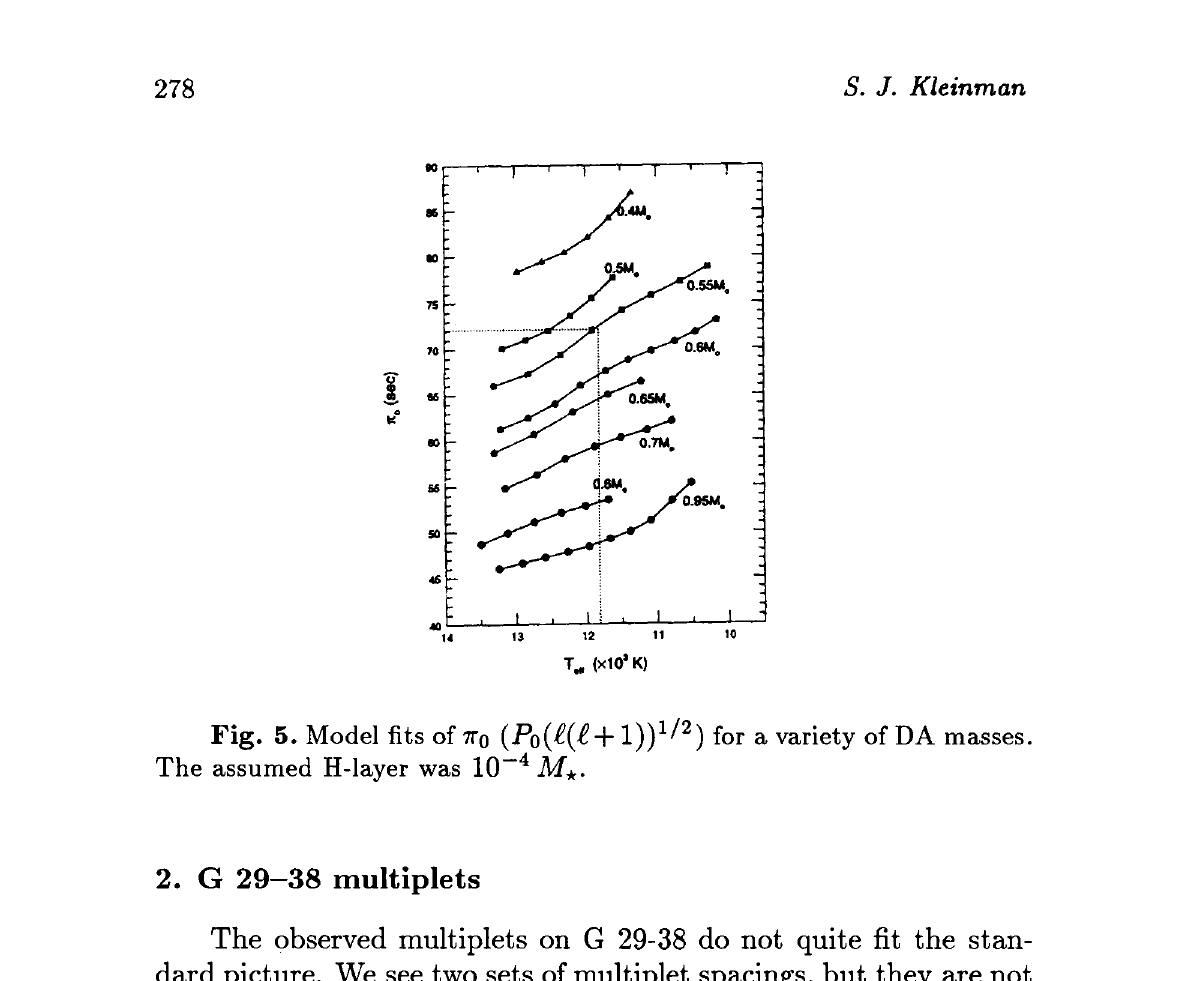
Fig. 5. Model fits of 7r The assumed H-layer was 10~ 4